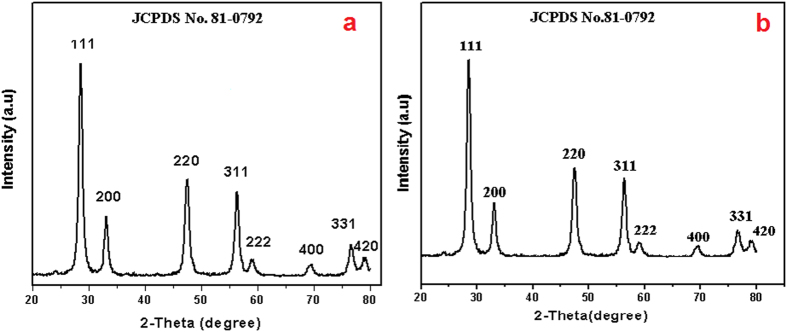
XRD pattern of (a) CeO2 NPs prepared by the MCM and (b) CeO2 NPs prepared by the CRSGM.